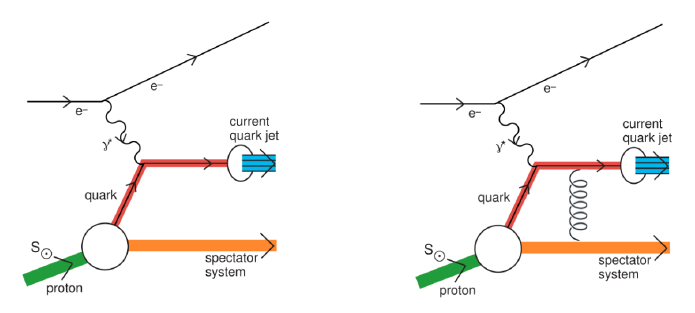
Figure 1: SIDIS without and with gluon exchange. Original figure from Ref. [ 4 ] .